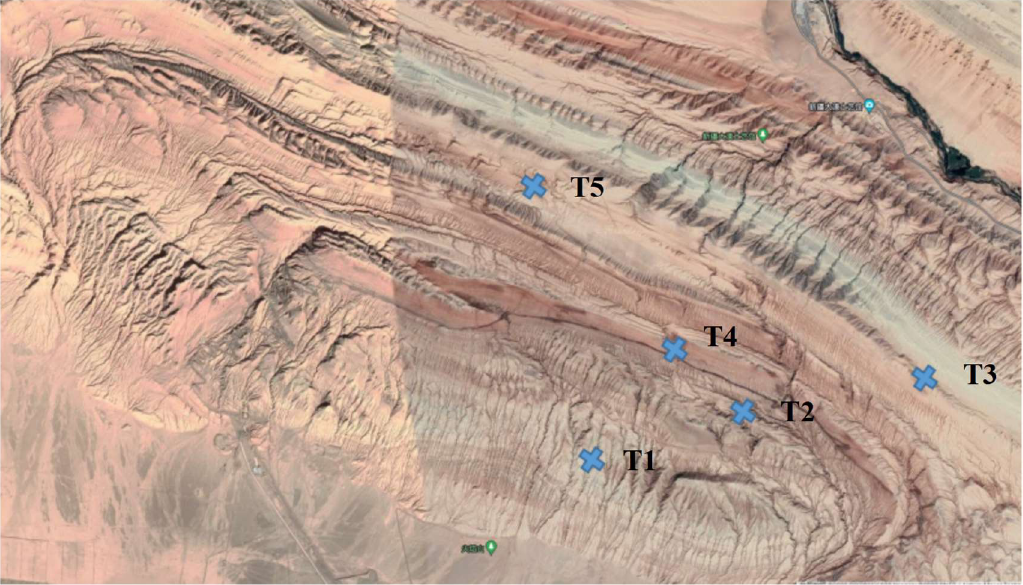
Figure 1. Location of sampling points in Flaming Mountain area (soil samples marked in blue). Table 1. Physical and chemical properties of soil samples from Flaming Mountain.